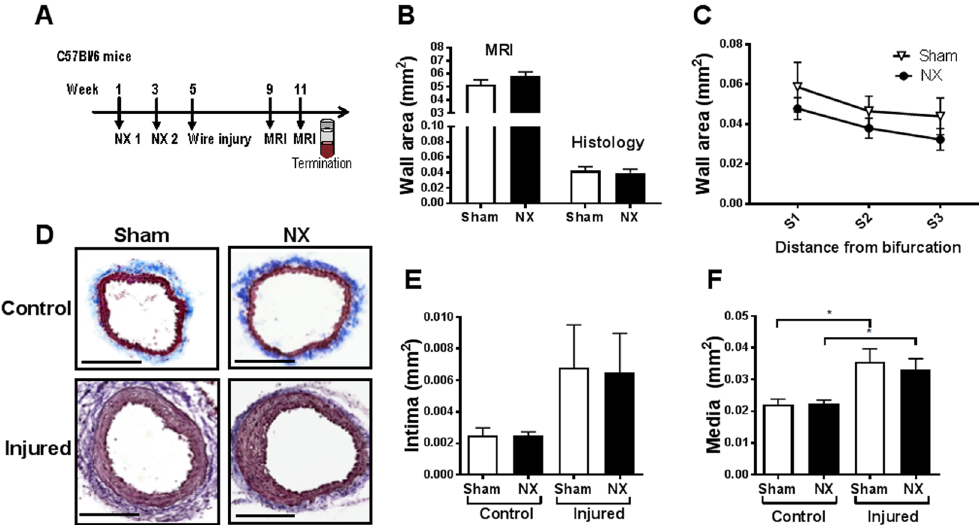
Figure 1. Uremia does not affect neointima formation in carotid arteries after vascular injury in C57BL/6 mice. ( A ) Study outline: C57BL/6 mice underwent 5/6 nephrectomy (NX) or sham operations in two steps (timepoints NX1 and NX2), and subsequently carotid wire injury and magnetic resonance imaging (MRI). ( B ) Quantification of cross-sectional vascular wall area by in vivo MRI (average of 4 cross-sections/mouse; n = 5 NX and n = 4 sham) and histology (average of 8–12 sections/mouse; n = 11 NX and n = 8 sham) in injured carotids of NX and sham C57BL/6 mice 6 weeks after wire injury. ( C ) Quantification of carotid wall area by histology. Three anatomical locations, series 1–3 (S1–S3, 2–4 sections/mouse/per series, n = 11 NX and n = 8 sham), were quantified. ( D ) Representative pictures of Trichrome stained injured and control carotid arteries from NX and sham mice. Scale bar, 200 μ m. ( E ) Quantification of cross-sectional intimal and ( F ) medial area in injured and control carotid arteries from NX and sham mice (average of 8–12 sections/mouse, n = 11 NX and n = 8 sham). Data are presented as mean ± SEM. Unpaired t-test ( B ) with correction for multiple comparisons